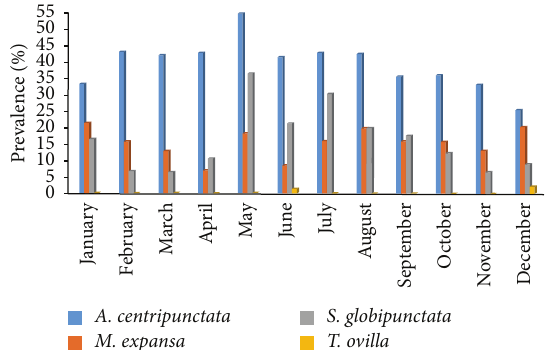
Figure 1: Monthly variation of prevalence of anoplocephalids in sheep.